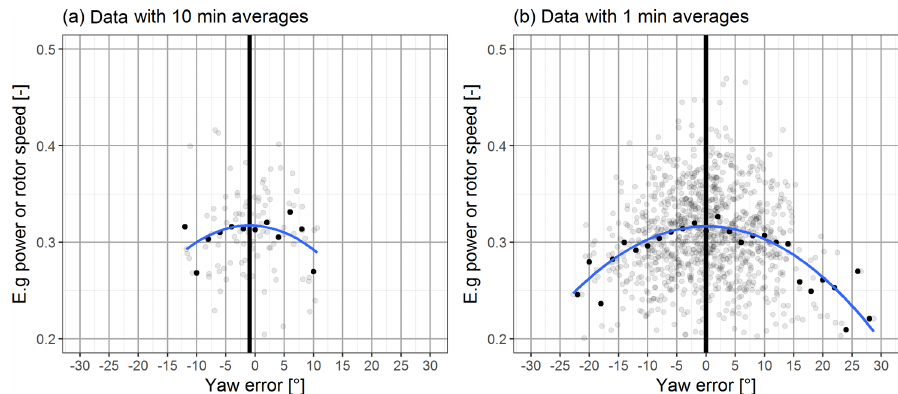
Figure 6. Example of the determination of the best operational alignment. The data are simulated with the same distribution derived from Fig. 5 with a mean yaw error of 0 ◦ and 1000min duration. Normalized active power or rotor speed for a specific wind speed bin as a function of the yaw error. The transparent dots are values with an averaging period of 1min (b) and 10min (a) . The solid dots represent the yaw error bin averages. The curved line is a second-order polynomial fit with the method of least squares. The maximum is highlighted with a vertical bar. Data with averages of 10min periods (a) show less curvature than data with 1min (b) , which can lead to small deviations for the derived mean yaw error.